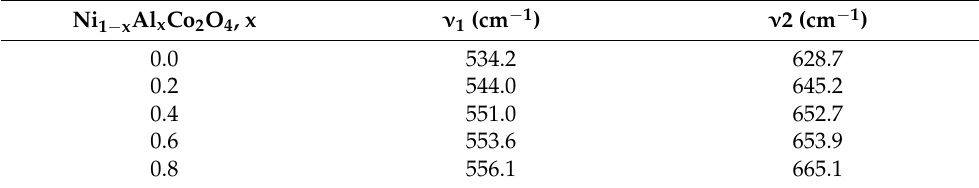
Table 3. Two distinct band positions from FTIR spectrum for Ni 1 − x Al x Co 2 O 4 samples.